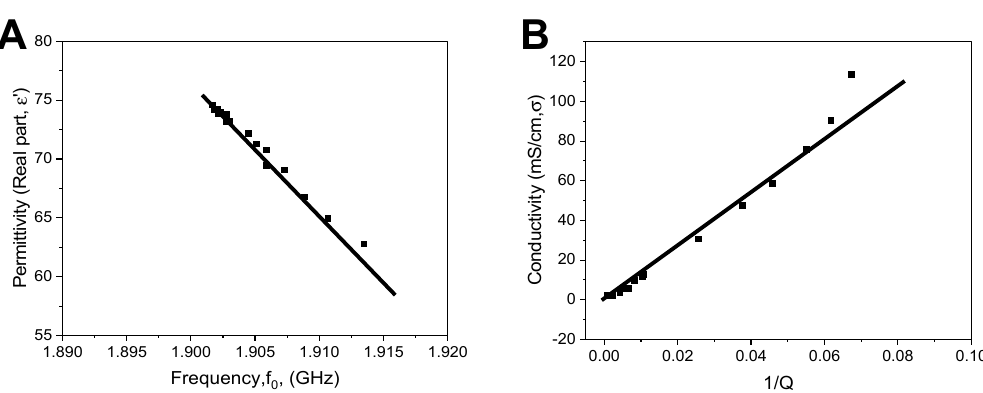
Figure 4. Calibration curves for determination of geometry parameters. ( A ) Ethanol and ( B ) KCl titration into water respectively allow the determination of permittivity and conductivity that enable the calculation of geometry parameters k 1 and k 2 .